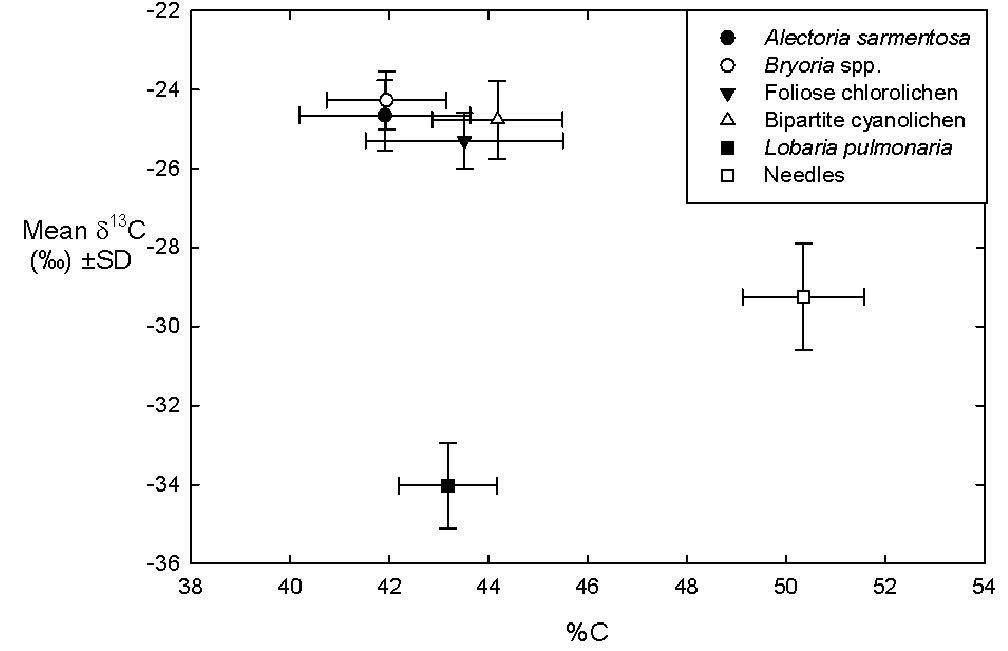
Figure 7. Mean (± SD) C concentrations versus δ 13 C signals of five epiphytic lichen functional group and host tree foliage (needle) biomasses across four sites and two host tree